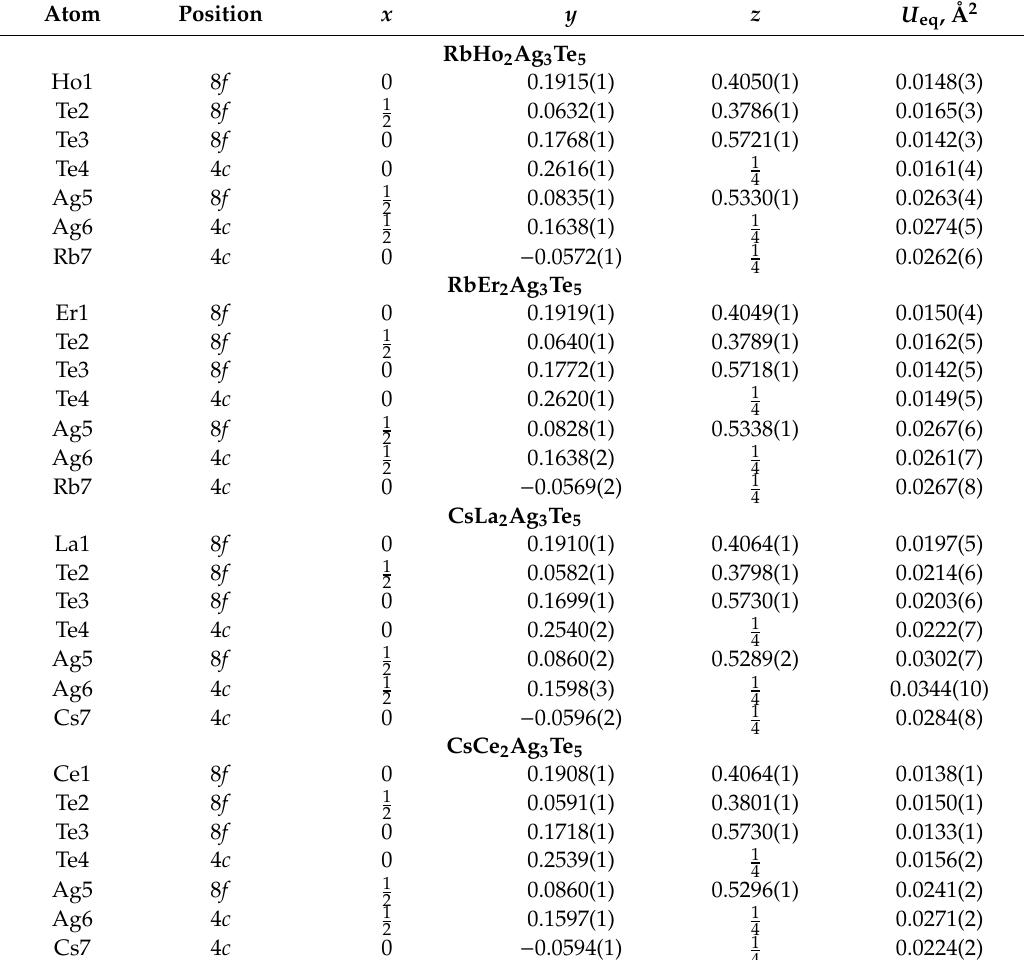
Table 2. Atomic positions and equivalent displacement parameters for RbLn 2 Ag 3 Te 5 (Ln = Ho, Er) and CsLn 2 Ag 3 Te 5 (Ln = La,